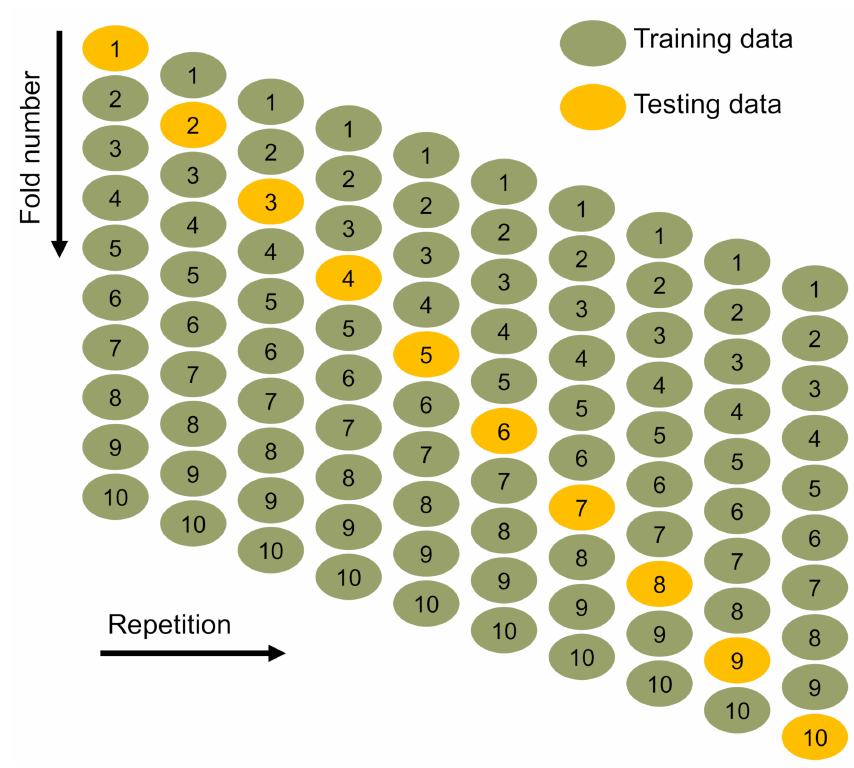
Figure 9. Schematic depiction of k-fold assessment